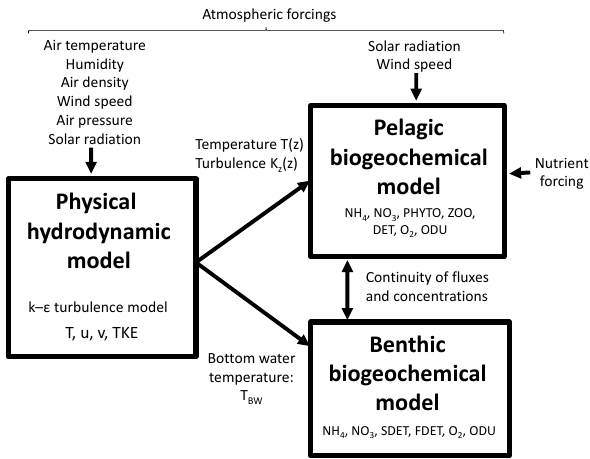
Fig. 2. The model consists of 3 submodels: a hydrodynamic k - ε model, a pelagic biogeochemical model and sediment biogeochem- istry model. Atmospheric forcings drive the physical model. Water temperature ( T ) and turbulent mixing coefficient ( K z ) are exported to the pelagic biogeochemical model, which is furthermore forced by solar radiation and wind speed. The bottom water temperature is exported to the benthic biogeochemical model. Fluxes of oxygen (O 2 ), nitrate (NO 3 ), ammonium (NH 4 ) and oxygen demand units (ODU) are exchanged across the sediment–water interface. Also de- position of organic material on the sediment is modelled which is split into fast (FDET) and slow (SDET) decaying